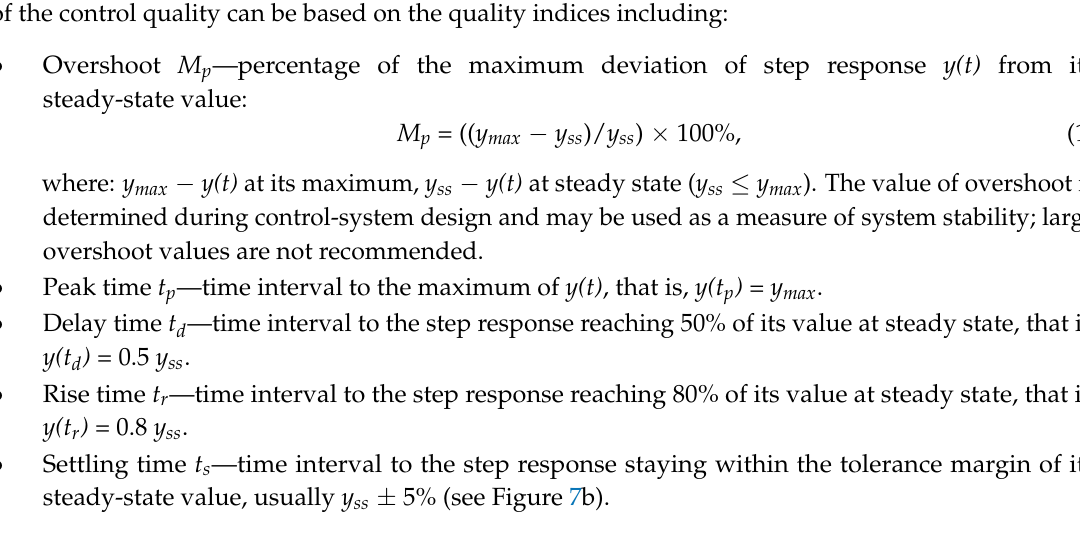
Figure 7. Scheme of a HE unit with PID temperature control ( a ) and closed-loop step responses of HE models: typical response ( b ), without adjustment ( c ) and after adjustment ( d ) of PID tuning parameters.